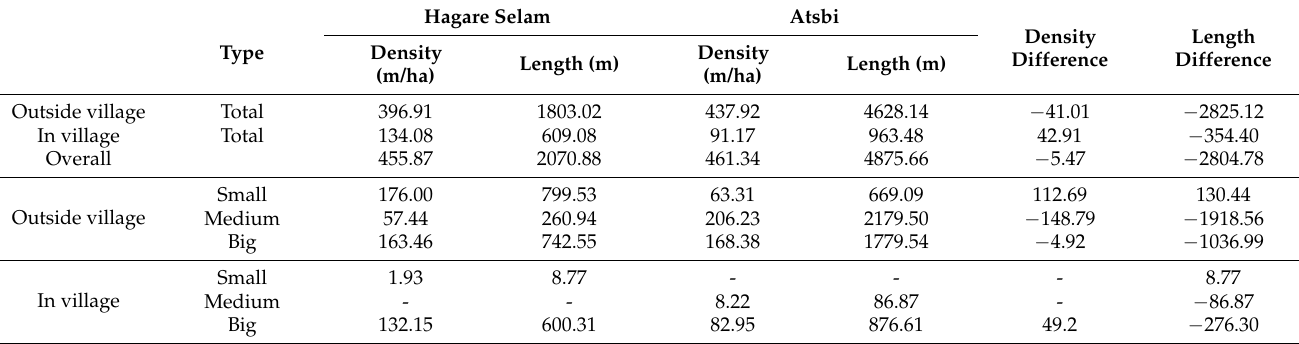
Table 6. Comparison of density and length of stone bunds for Atsbi (4.54 ha) and Hagere Selam (10.75 ha) as obtained from the drone image analysis. “-” = no such type of stone